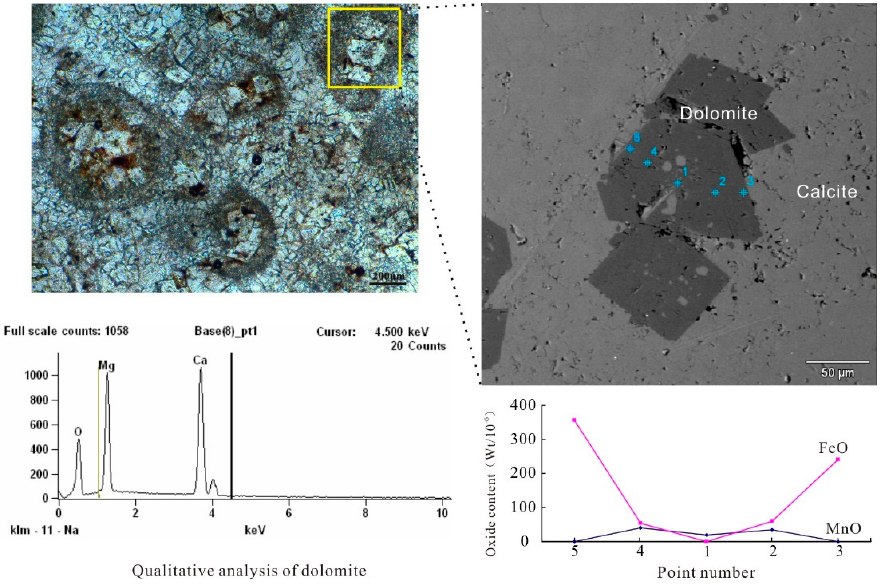
Figure 6. Fe and Mn oxide composition curve of CCCR dolomites (sample YA-74-1).